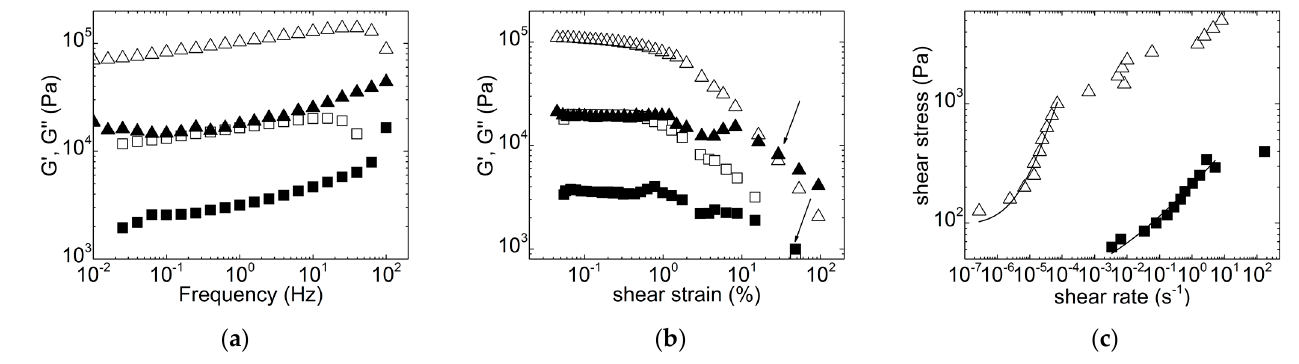
Figure 1. Mechanical spectra ( a ), dynamic stress sweeps ( b ) and flow curves ( c ) performed on biomass premixes with distilled water: 50 g with 50 mL (triangles) and 30 g with 70 mL (squares). In ( a , b ): G’ is displayed as open symbols; G’’ is displayed as filled symbols. Arrows in ( b ) indicate the strains where slurries are fluidized, whereas lines in ( c ) are fits of Equation (1) to the data. Both feeds displayed a viscoelastic and predominantly solid character.